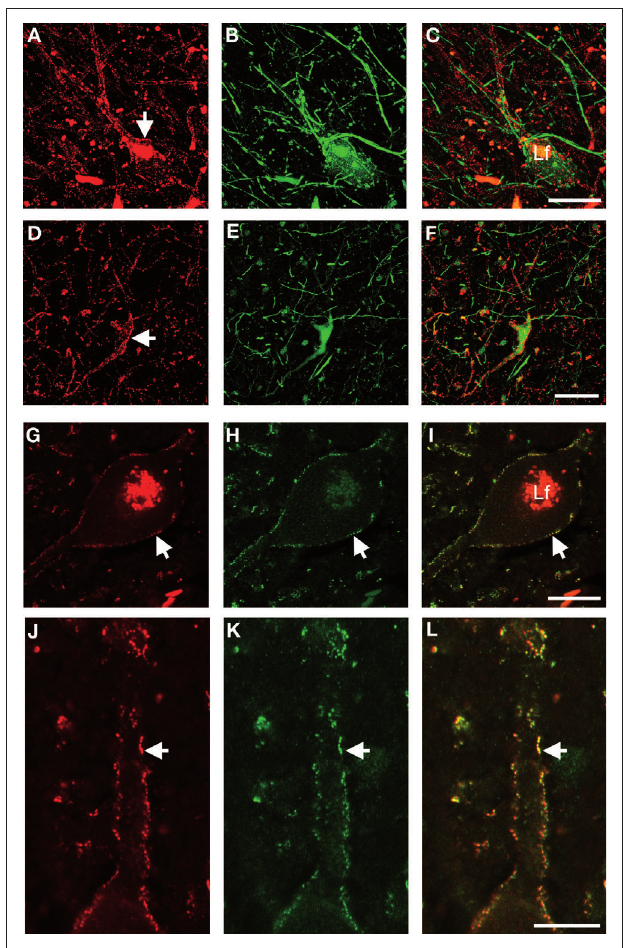
FIGURE 3 | High-resolution confocal laser scanning microscopy images of neurons in the substantia nigra pars reticulata (A–C), putamen (D–F), and fi rst cervical segment of the spinal cord (G–L) of the human CNS double-labeled for GlyR (left column) and other cell markers (middle column) with combined images shown in the right column. (A–C) Neuron in the substantia nigra pars reticulata is labeled red for GlyR [mAb4a in (A) , arrow] and immunopositive for rabbit anti-parvalbumin [green in (B) ], green unlabeled parvalbumin processes in the picture resemble axon bundles, combined images in (C) . (D–F) Neuron in the putamen that is outlined with GlyR-IR [mAb4a, red in (D) , arrow] is labeled with rabbit anti-